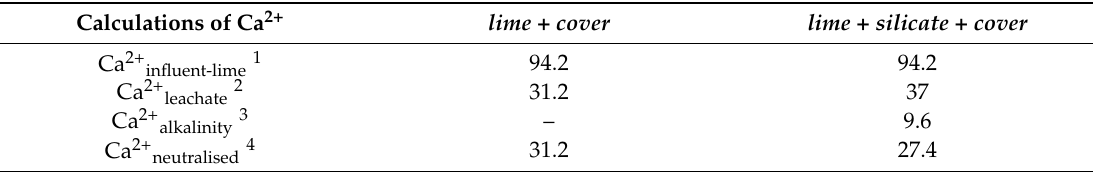
Table 7. Mass balance calculations of Ca 2+ (mmol) for lime + cover and lime + silicate + cover between weeks